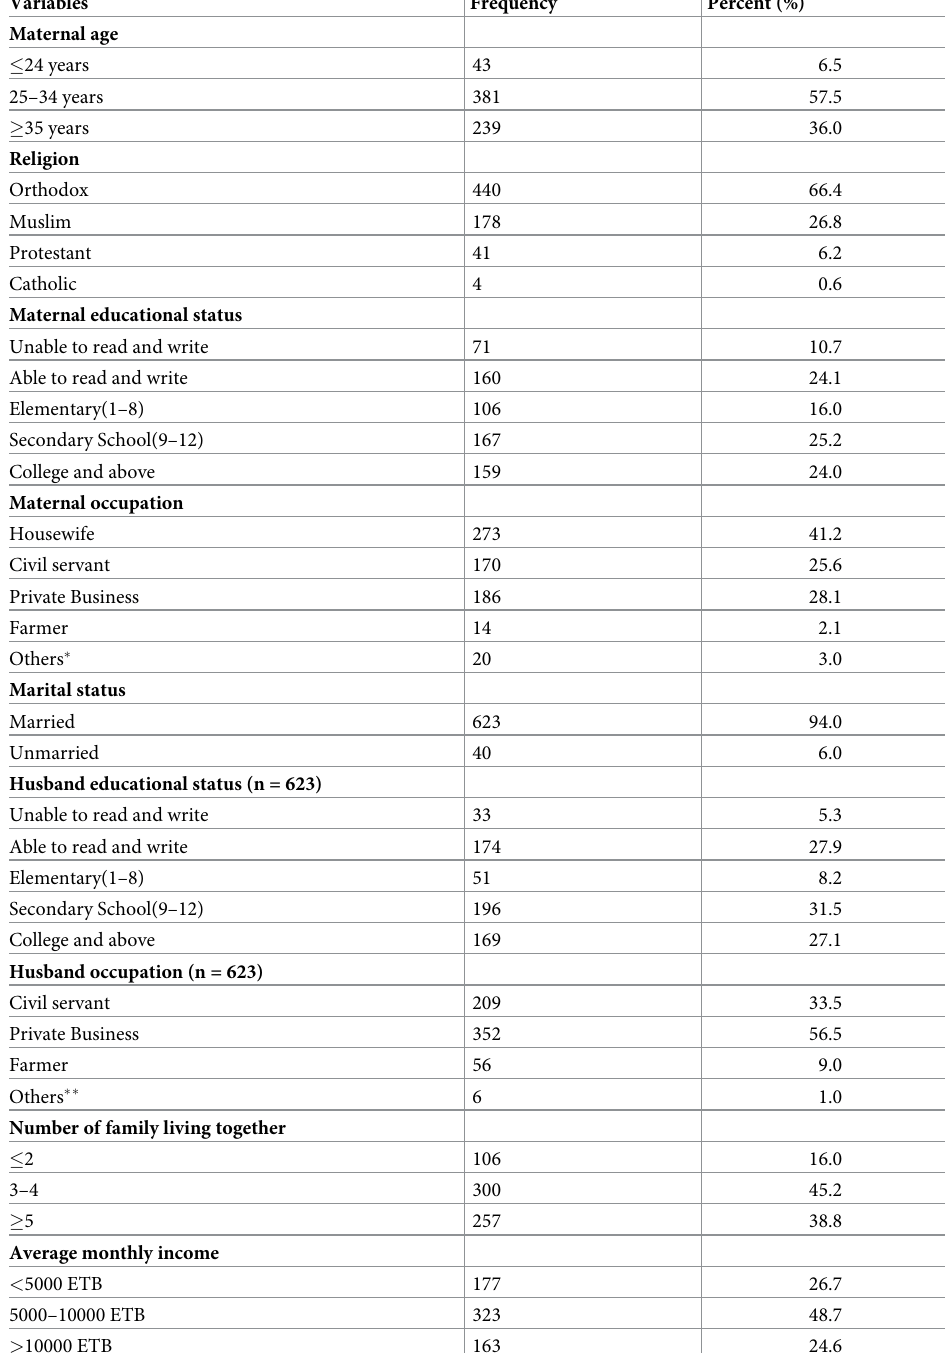
Table 1. Sociodemographic characteristics of pregnant women in Gondar city, northwest Ethiopia 2021 (n =